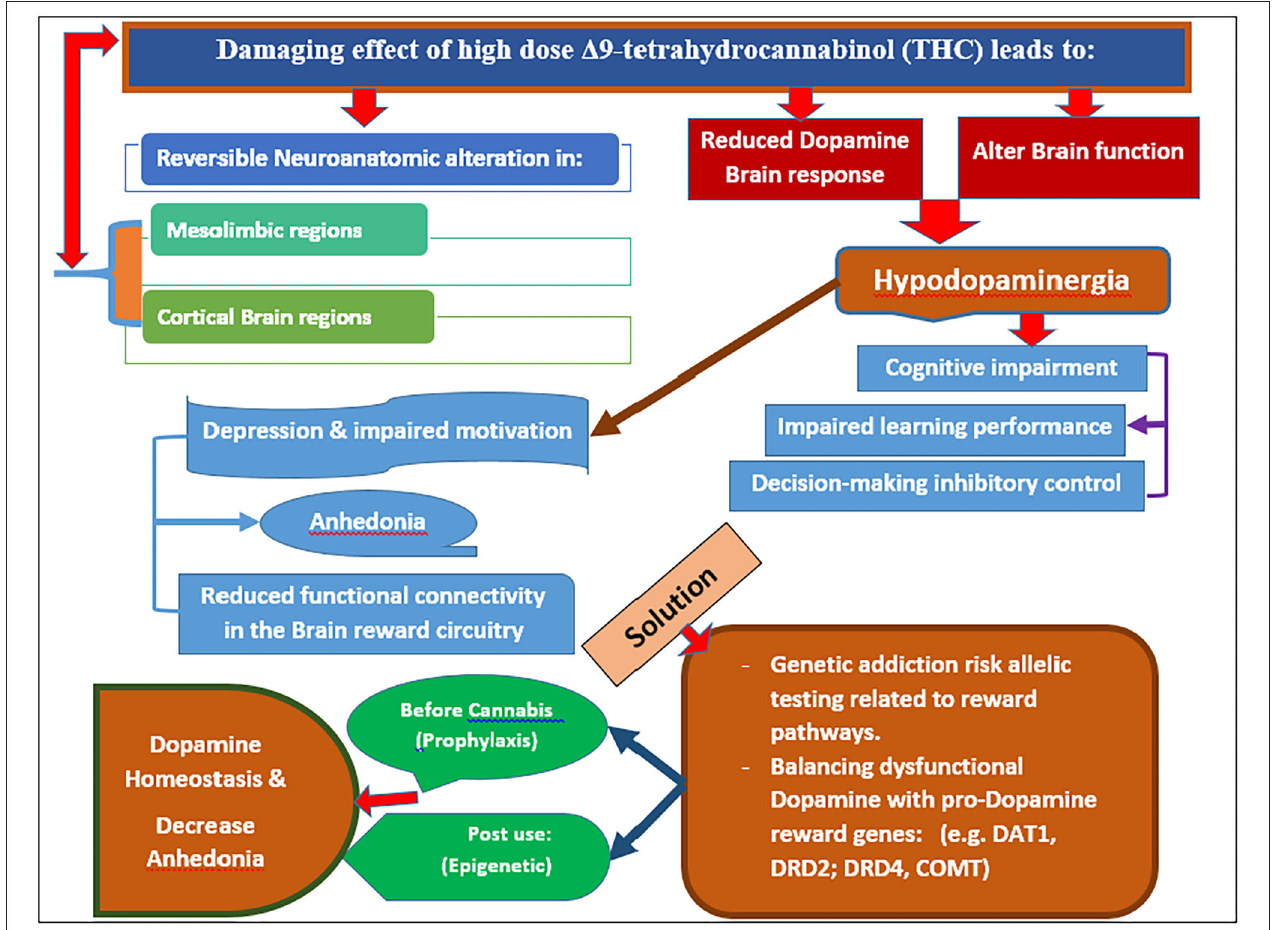
FIGURE 1 | It is a Model proposed for combatting chronic use of potent cannabis and anhedonia (Original figure Blum 2020). Note: Potency of cannabis may be as high as 90% THC in gummies and vaping